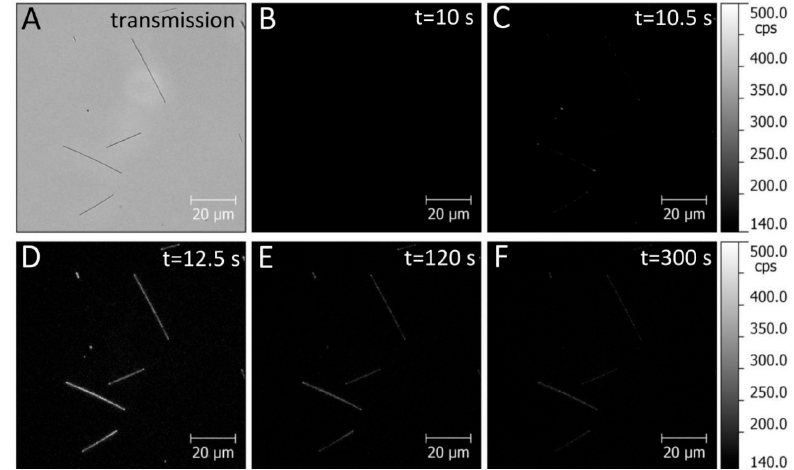
Figure 2. ( A ) Transmission image of silver nanowires ( AgNWs) prior to deposition of the PCP solution, ( B ) fluorescence image of AgNWs prior to deposition of the PCP solution, ( C – F ) fluorescence maps of PCP emission acquired at indicated times. The intensity scale of all the images is identical, and the solution of PCP complexes was added at t = 10 s.